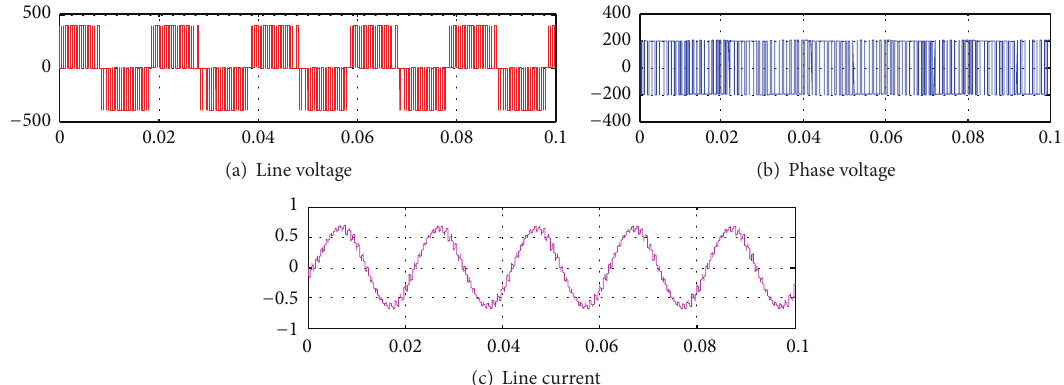
Figure 11: Conventional two-level inverter.